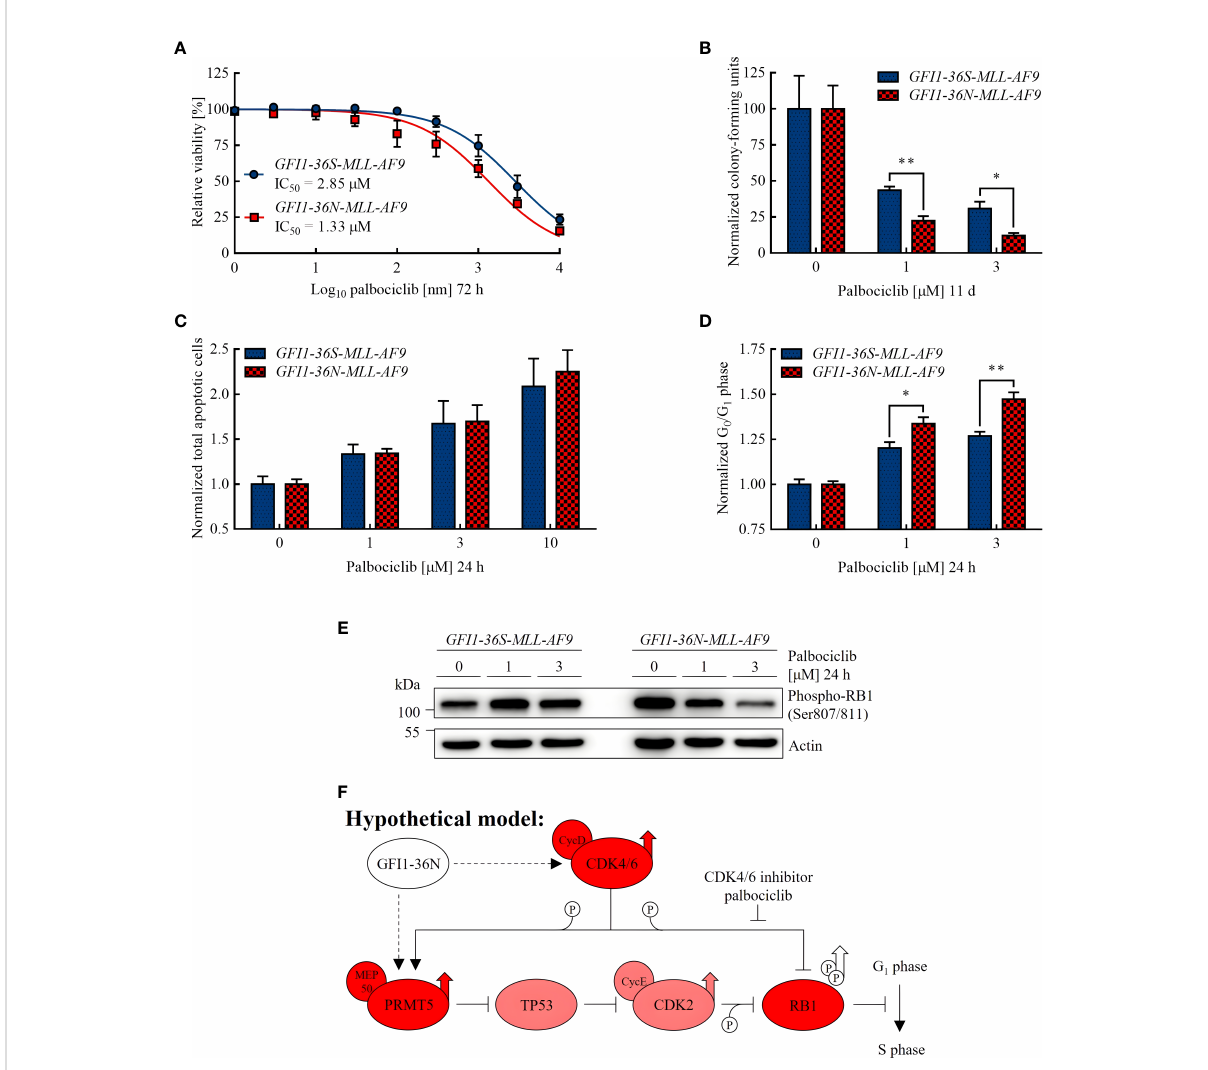
FIGURE 3 GFI1-36N leukemic cells are more sensitive to CDK4/6 inhibition. (A) Cell viability after 72 h of palbociclib treatment. (B) Normalized CFUs after 11 d of palbociclib treatment. (C) Normalized total apoptotic cells after 24 h of palbociclib treatment. (D) Normalized cells in G 0 or G 1 phase after 24 h of palbociclib treatment. (E) Phospho-RB1 protein level detected by immunoblotting after 24 h of palbociclib treatment. (F) Hypothetical model of the in fl uence of the GFI1-36N protein on cell cycle regulation: Presence of the GFI1-36N variant is correlated with higher CDK4/6 and PRMT5 protein levels leading to RB1 inactivation by phosphorylation and thus cell cycle progression (simpli fi ed Figure 1 in Sheppard and AbuHammad 2019 (42) modi fi ed according to Figures 1 and 2 of this manuscript). Mean ± SEM ( n = 3 – 6); p * ≤ 0.05, p ** ≤